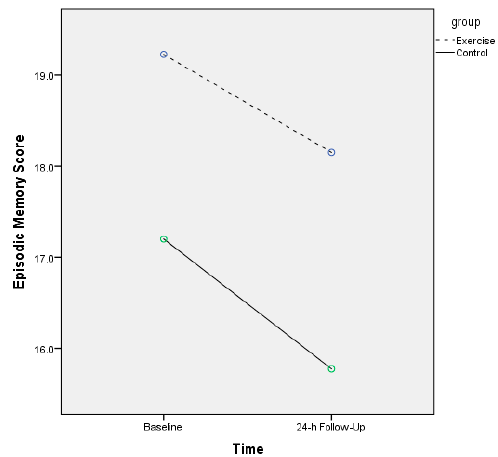
Figure 2. Episodic memory function scores across the experimental and control groups.